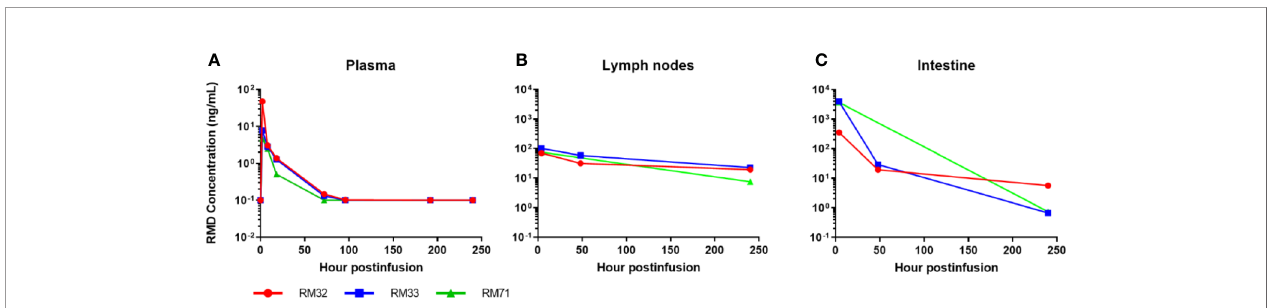
FIGURE 2 | Romidepsin concentrations in plasma and tissue post 4-h infusion of 7 mg/m 2 . RMD concentrations of 3 SIV-naïve RMs in plasma (A) , lymph node (B) , and intestinal tissue (C) .